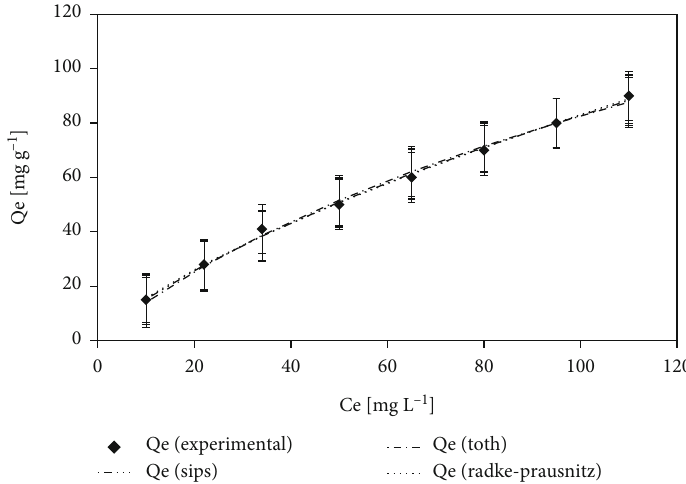
Figure 12: Adsorption data fi tting to Sips, Toth, and Radke-Prausnitz